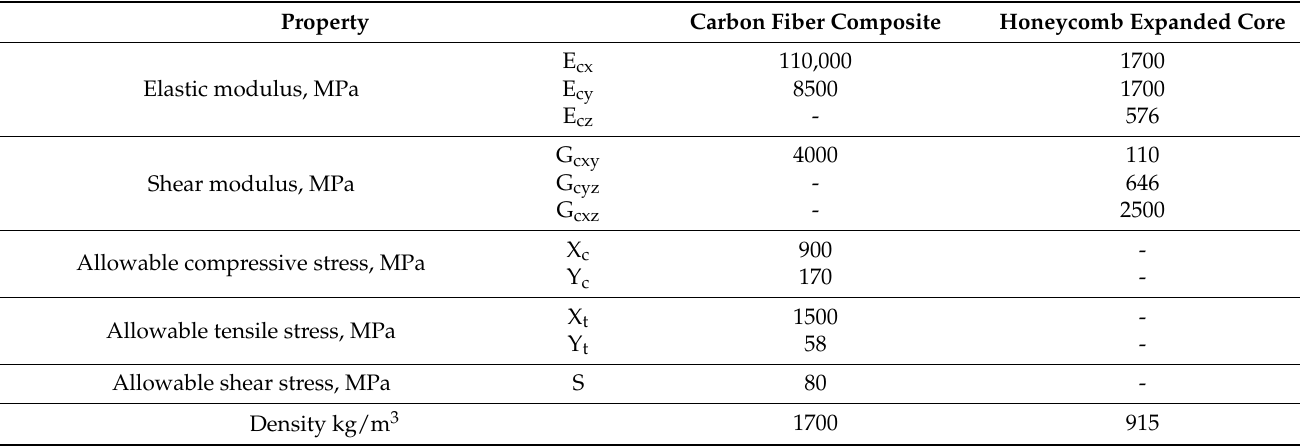
Table 1. Anisotropic material properties used in the study